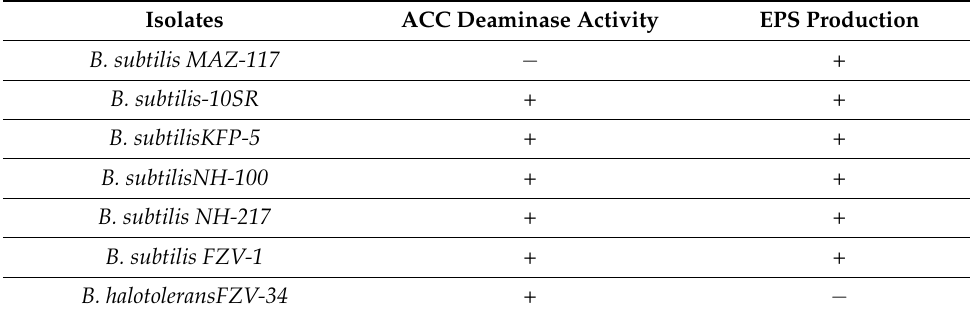
Table 3. ACC deaminase activity and EPS production in Bacillus